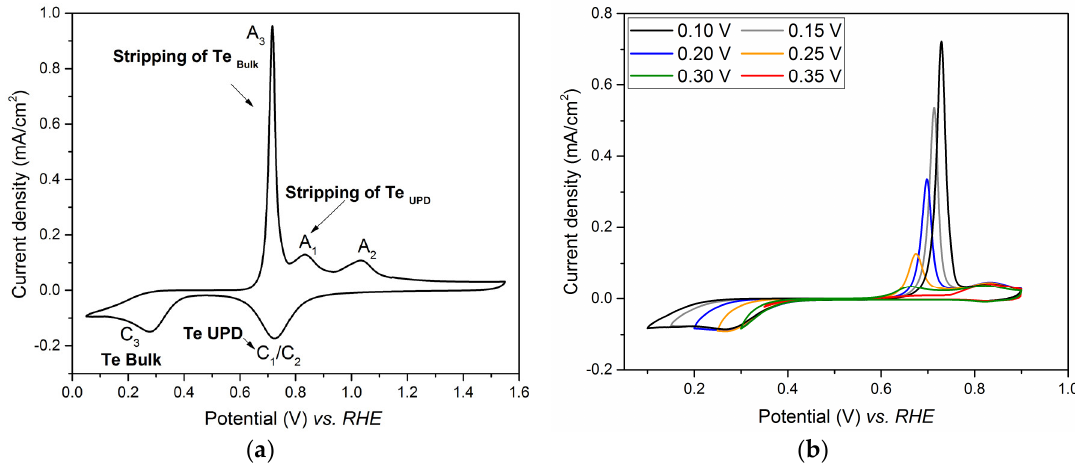
Figure 2. Cyclic voltammograms performed on Pt electrode in 1 mM TeO 2 + 0.4 M HClO 4 solution with a scan rate of 40 mV/s. ( a ) potential comprised between 1.60 V and 0.05 V; ( b ) potential from 0.9 V to various cathodic potential limits (0.35 V, 0.30 V, 0.25 V, 0.25 V, 0.15 V and 0.10 V).